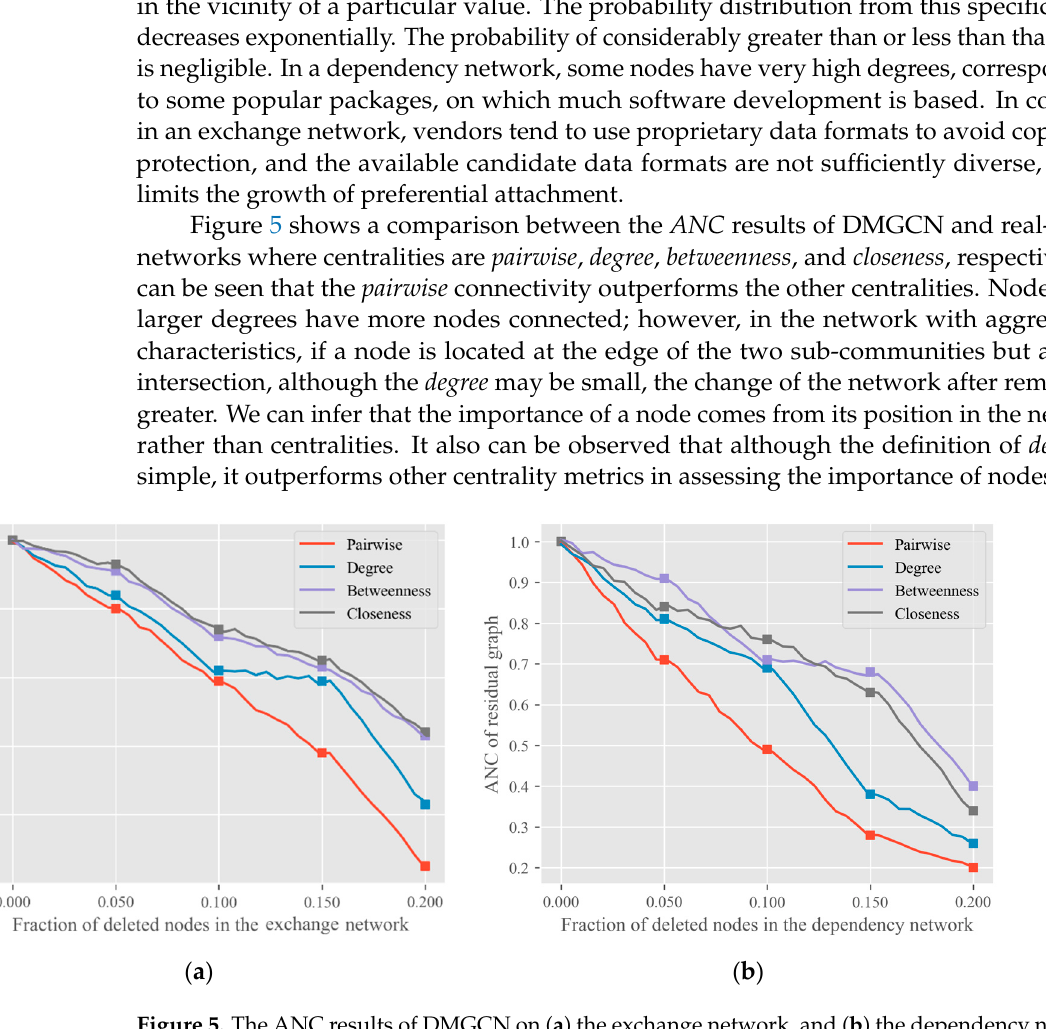
Figure 6. Performance comparison between the proposed method (DMGCN) and other heuristic methods in the 9/11 criminal network. The x -axis represents ANC results from pairwise connectivity. DMGCN1 refers to the model trained by small-world networks, and DMGCN2 refers to the model trained by scale-free networks. 5. Conclusions The derivation of data formats and tools has facilitated the dissemination of product information, while a wide variety of formats and tools have posed new challenges to the